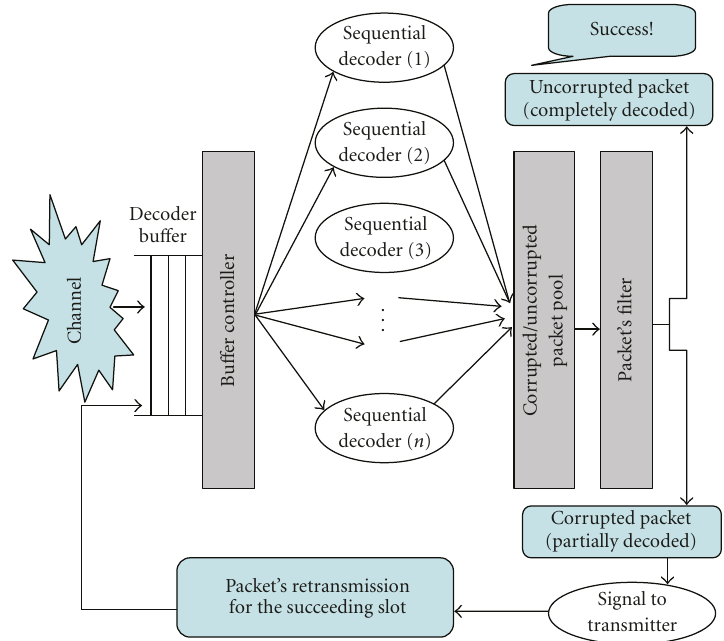
Figure 10: Router system with parallel sequential environment and single address space structure.